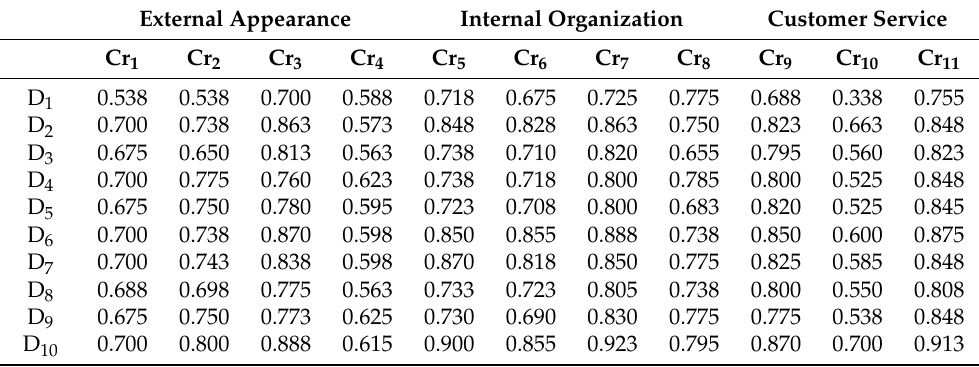
Table 6. Valuations of experts.